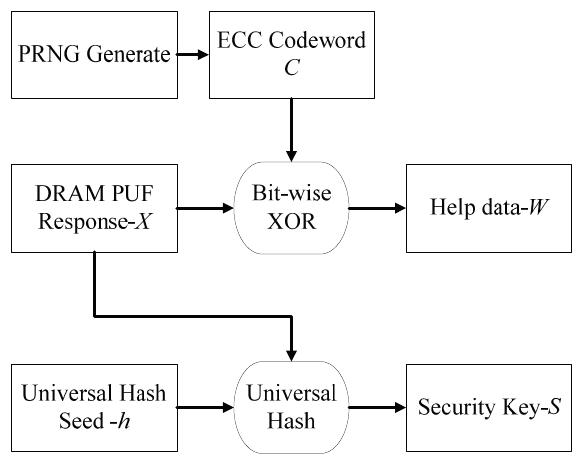
Figure 3. The flow chart of enrolment